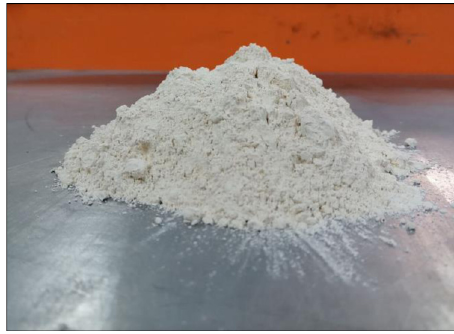
Figure 2: Glass powder utilized in